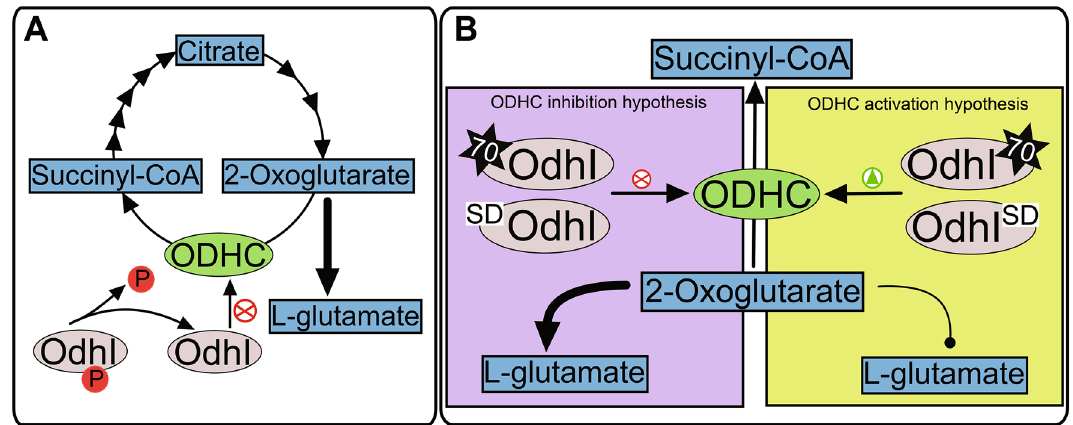
Figure 5. Representation of known and putative OdhI interactions with ODHC and its impact on l-glutamate production. ( A ) Interaction of OdhI and ODHC hampered by OdhI phosphorylation. The absence of the phosphate group on OdhI results in its interaction and inhibition of ODHC (represented by the red symbol), and flux to l-glutamate production is enhanced (represented by the large arrow from 2-oxoglutarate to l-glutamate) 11,37 . ( B ) Depiction of possible metabolic effects and protein interactions affected by OdhI proteoforms described in this study: Δm of 70 Da (represented by the star symbol), and N-terminal dipeptide cleavage (represented by the SD letters on OdhI). The effect of identified proteoforms on OdhI function remains unclear, however potential affected mechanisms are represented through the inhibition of ODHC (purple box; enhancement of L-glutamate production symbolized by the large arrow), or activation of ODHC (green box; decrease of L-glutamate production symbolized by the line with a dote). Both hypothesis may influence l-glutamate production. OdhI oxoglutarate dehydrogenase inhibitor, ODHC oxoglutarate dehydrogenase